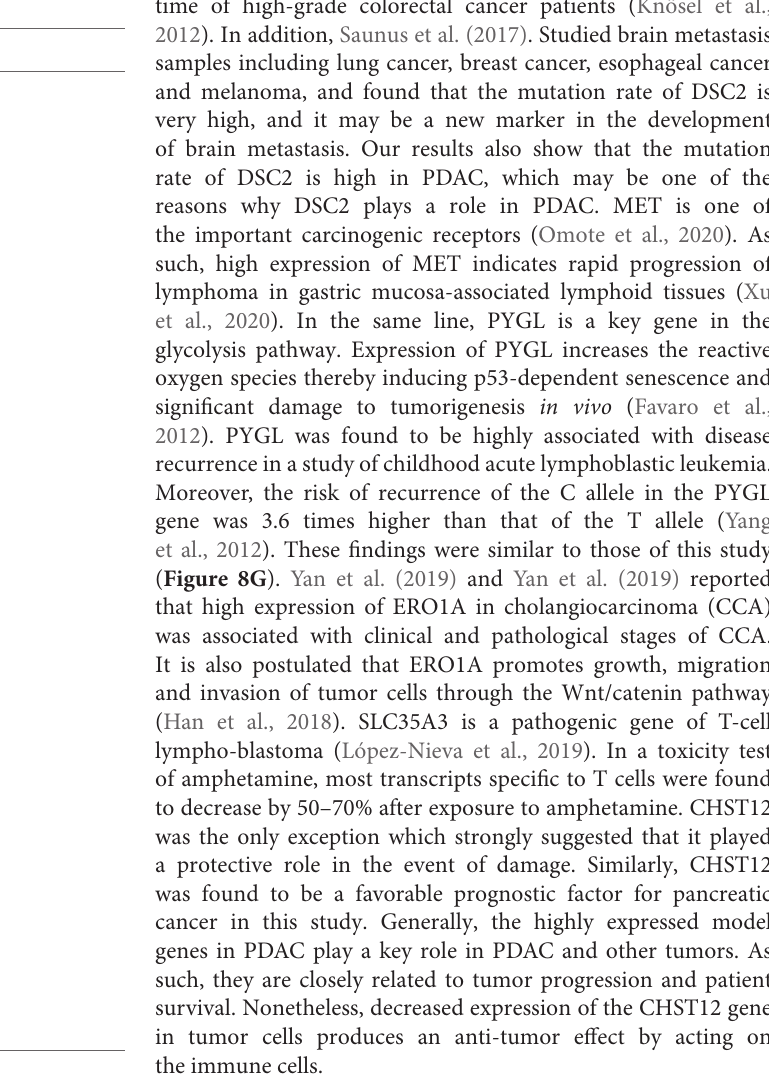
TABLE 2 | TCGA clinical